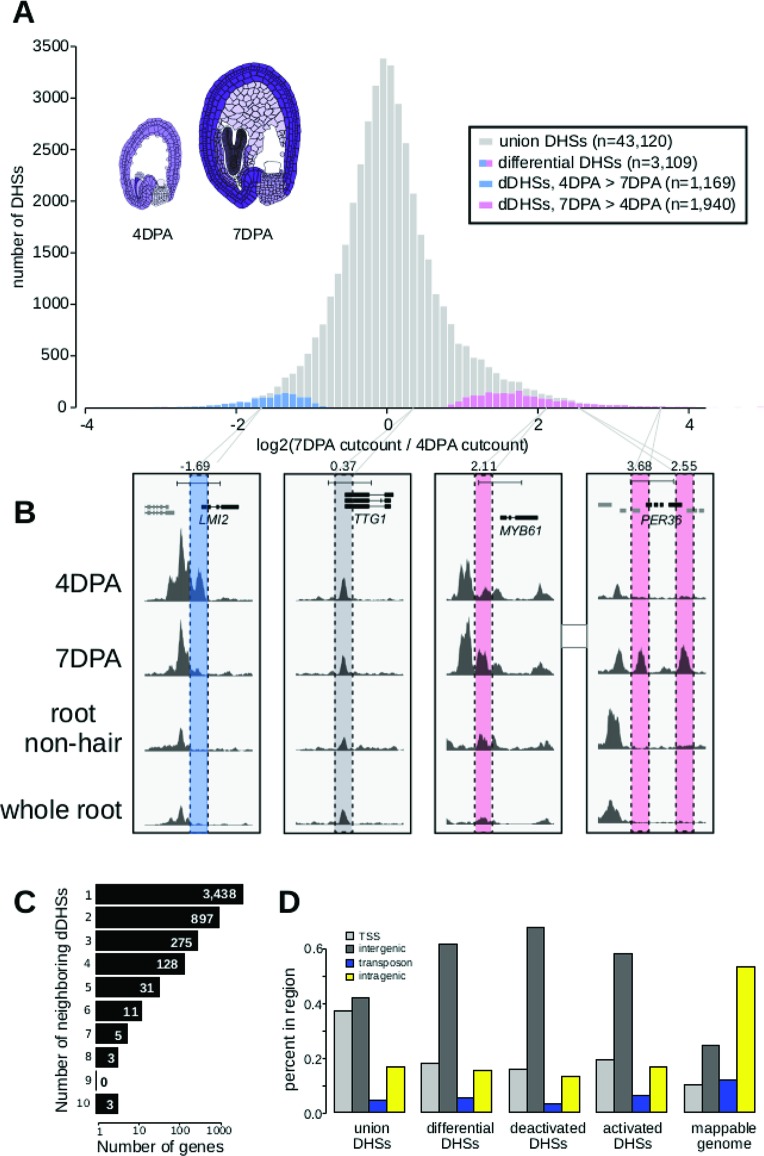
The chromatin landscape of maturing seed coat cells. (A) Distribution of log2(DNase I cut count in 7 DPA/DNase I cut count in 4 DPA) for all union DNase I-hypersensitive sites (DHSs) (gray) and dynamic DHSs, with DHSs more accessible at 4 DPA appearing on the left in blue and DHSs more accessible at 7 DPA appearing on the right in pink. Diagrams of 4 DPA (left) and 7 DPA seeds (right) are shown, with purple opacity indicating GL2 expression levels from Belmonte et al., 2013. (B) Examples showing a deactivated DHS, two examples of activated DHSs, and one example of a static DHS. A 5-kb region is shown in each window; all data tracks are read-depth normalized. (C) Distribution of the number of dynamic DHSs neighboring genes. Most genes reside next to one dynamic DHS; however, surprisingly many genes reside next to multiple dynamic DHSs. Genes neighboring dynamic DHSs are listed in
Supplemental Table 13
. (D) The numbers of union DHSs (uDHSs) and dynamic DHSs (dDHSs) within each genomic context: TSS, intergenic, transposon, and intragenic.